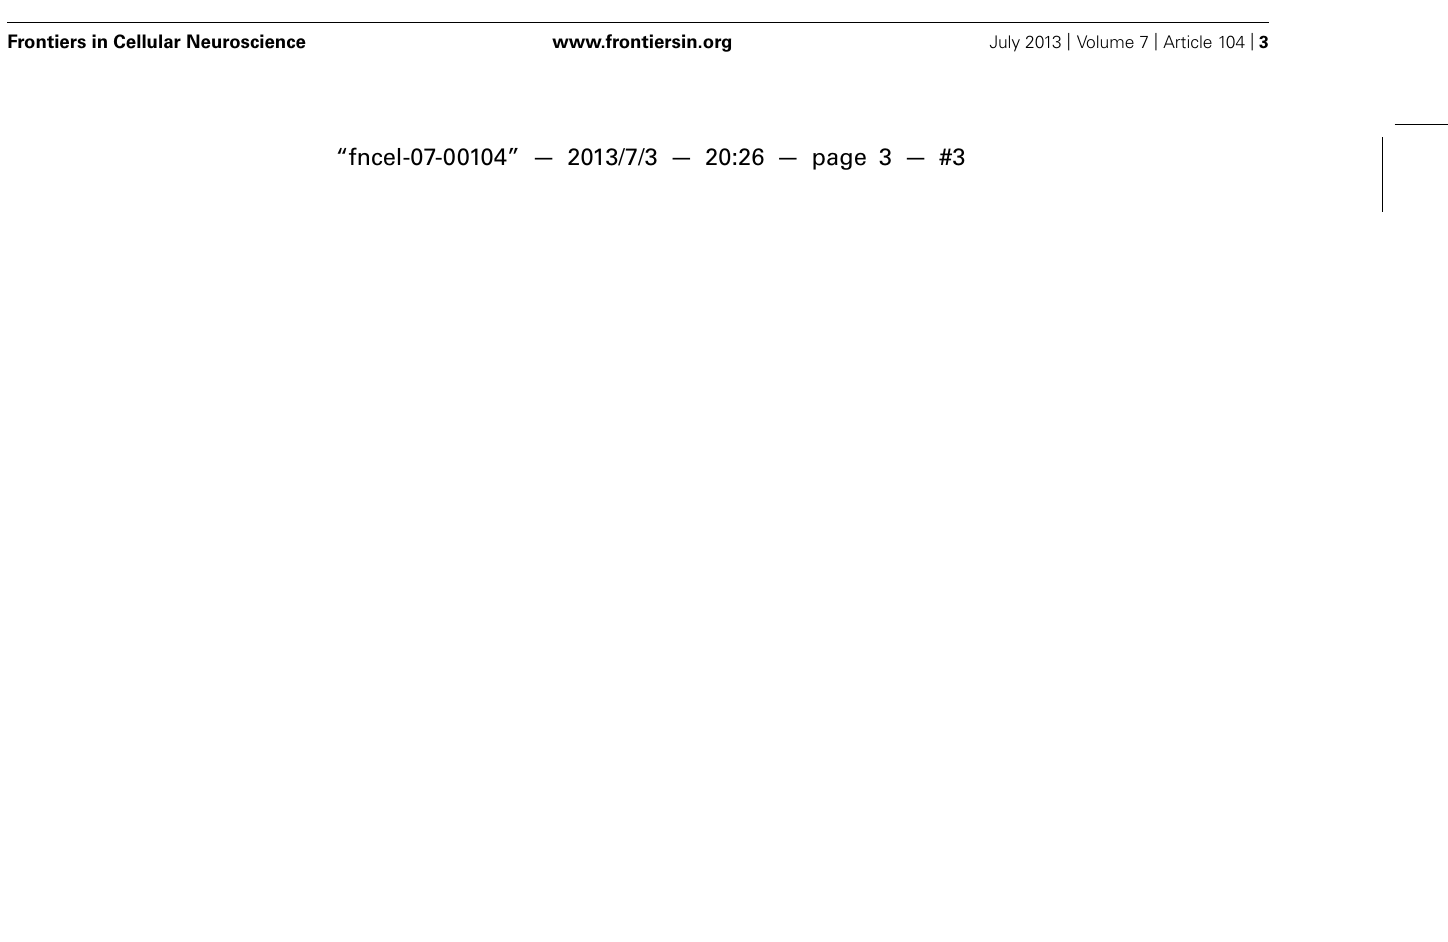
and AcbSh, core and shell regions of nucleus accumbens, respectively; Ect-PRh, ectorhinal–perirhinal cortex; MePV and MePD, medial amygdaloid nucleus, posteroventral and posterodorsal part; BLP, basolateral amygdaloid nucleus, posterior part; BMP, basomedial amygdaloid nucleus, posterior part; PMCo, posteromedial cortical amygdaloid nucleus; CA1, CA3, and DG: CA1, CA3, and dentate gyrus of the hippocampus. (B) Representative photographs illustrating the Kir4.1 (upper panels)- and GFAP (lower panels)-positive cells in the sensory cortex (SC) and the medial amygdaloid nucleus, posterodorsal part (MePD). Scale bar: 50 μ